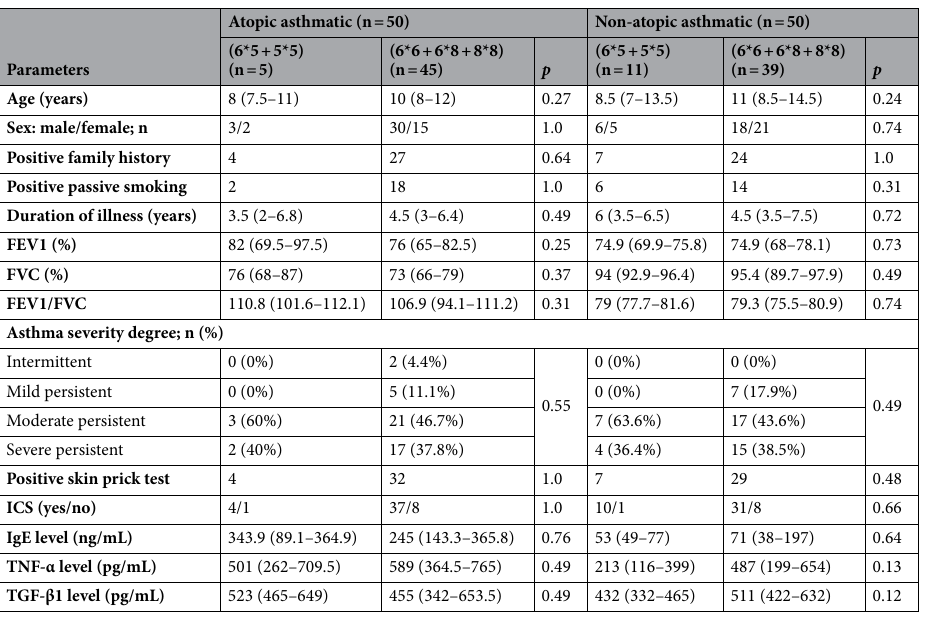
Table 5. Associations of MUC7 VNTR genotypes with demographic, clinical features, and biochemical measurements in atopic and non-atopic asthmatic patients. Data are presented as numbers with percentages or median with interquartile range. Chi square and Mann–Whitney U tests were applied. FEV1 forced expiratory volume, FVC forced vital capacity, ICS inhaled corticosteroids, IgE immunoglobulin E, TNF-α tumor